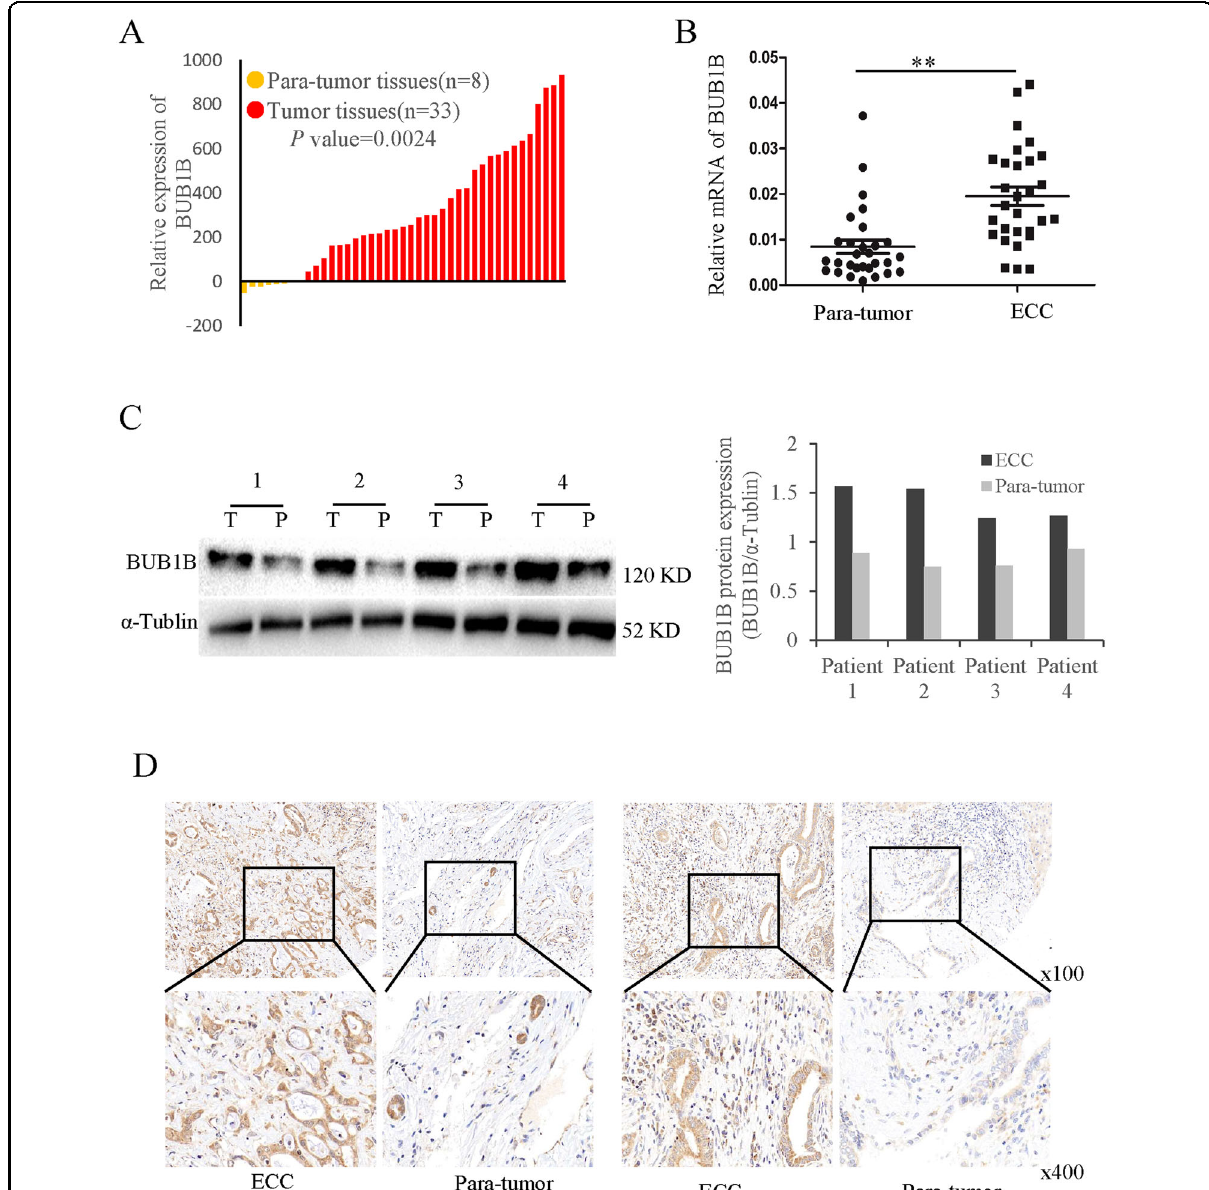
Fig. 1 BUB1B was up-regulated in ECC tissues. A BUB1B was upregulated in CCA tumor tissues compared to paratumor in public TCGA database. B Our center samples also con fi rmed the expression mRNA level of BUB1B was upregulated in ECC tissues compared with their corresponding paratumor tissues. C The protein expression was determined for ECC samples by western blot. D BUB1B expression in the paired ECC samples was con fi rmed by IHC staining. The western blot and IHC staining illustrated that higher expression of BUB1B was found in ECC tissues (* p < 0.05, ** p <